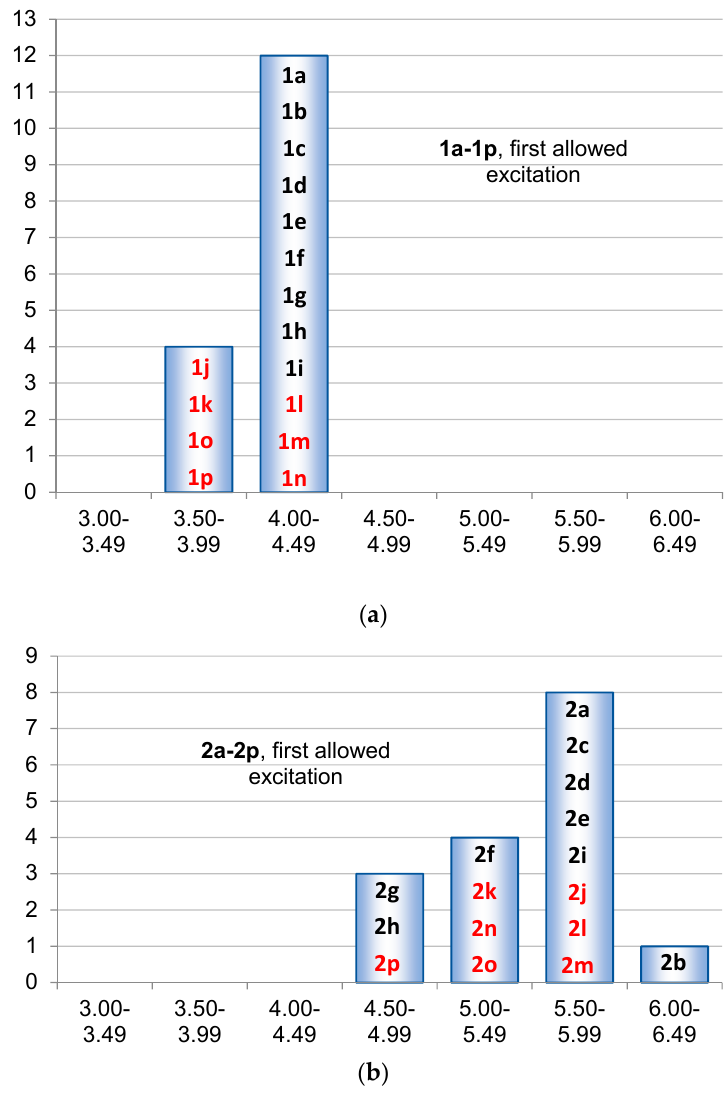
Figure 12. The distributions in the vertical excitation energies for the first allowed transitions to singlet excited states of ( a ) 1a – 1p and of ( b ) 2a – 2p calculated at TD-PBE0/6-31+G(2d,p)// PBE0/6-31G(d) level. Compound numbers of compounds substituted at the Si atoms in black and those substituted at the C atoms in red.